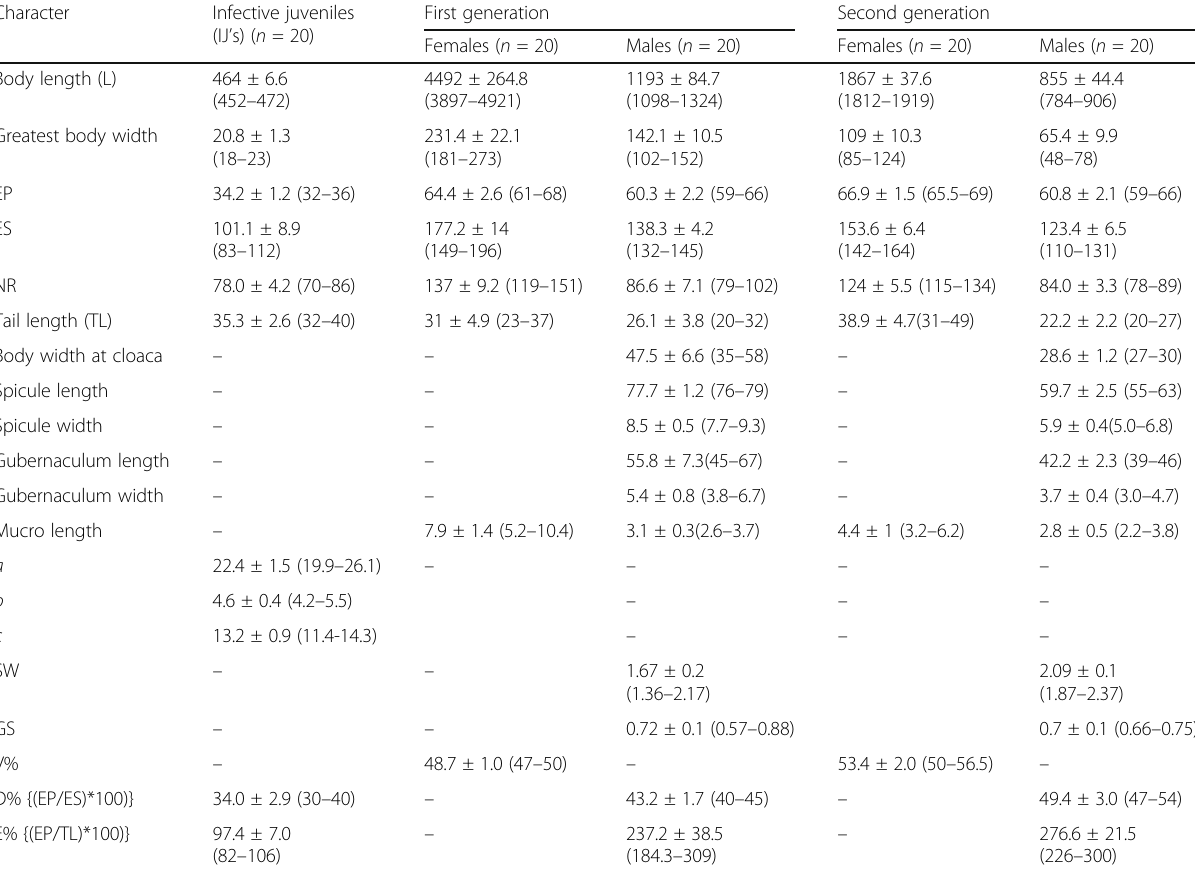
Table 2 Morphometrics of Steinernema siamkayai (IIVR JNC01 strain) (measurements are in μ m and in the form of mean ± SD